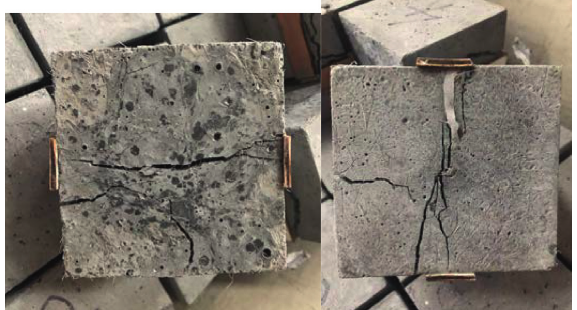
Figure 10: Appearance of the specimen after splitting tensile